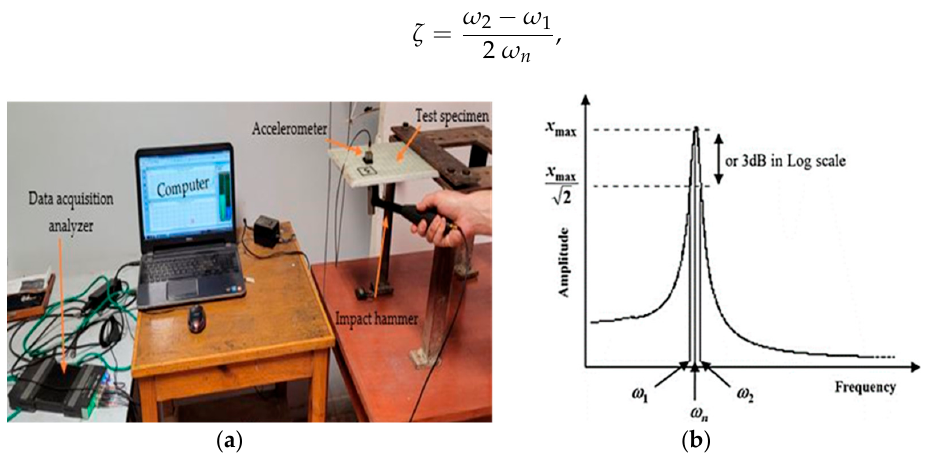
Figure 2. ( a ) Overall view of vibration test set-up, ( b ) Half power bandwidth method.